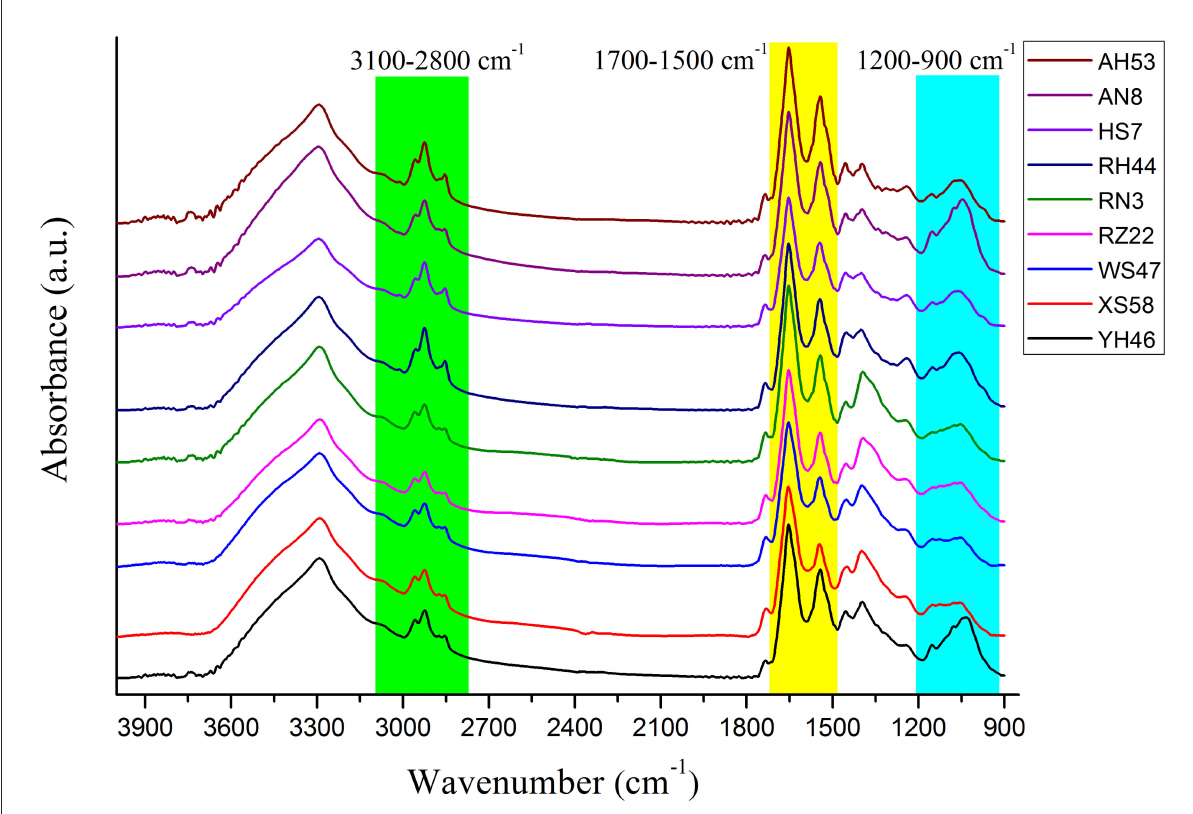
FIGURE2 The average FTIR raw spectra and the truncated spectra for different Spirulina